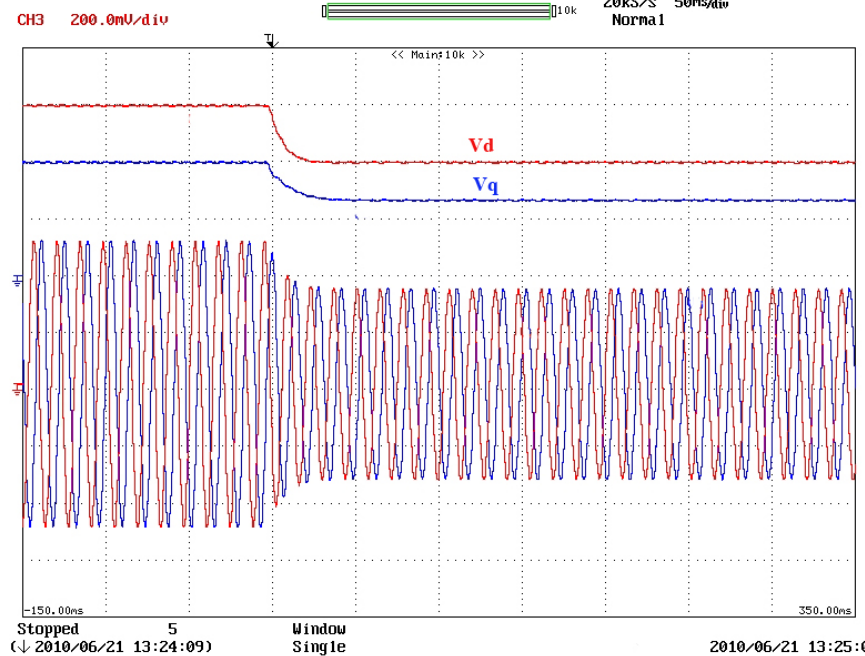
Figure 11. Oscilloscope screen capture of the d and q components of the load voltage, and the phase a and b voltages of the load.